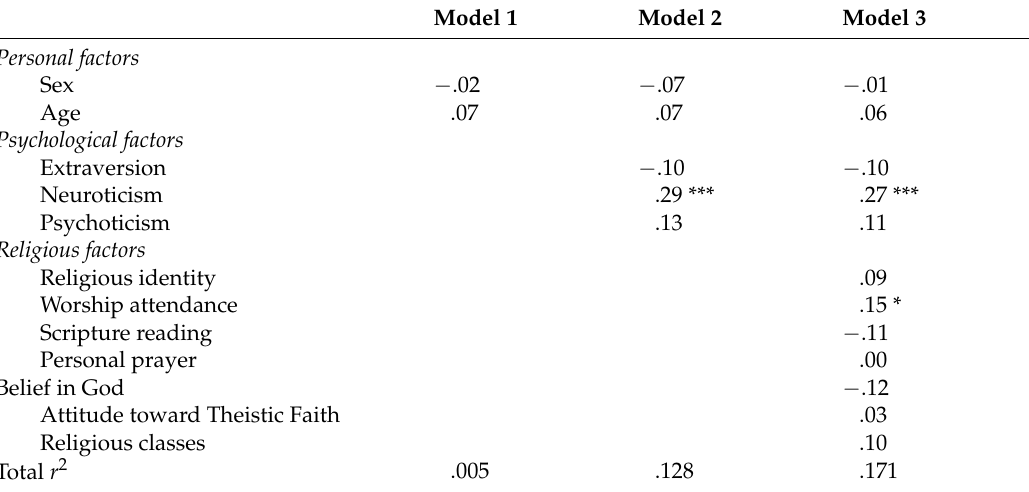
Table 5. Regression models on experience of